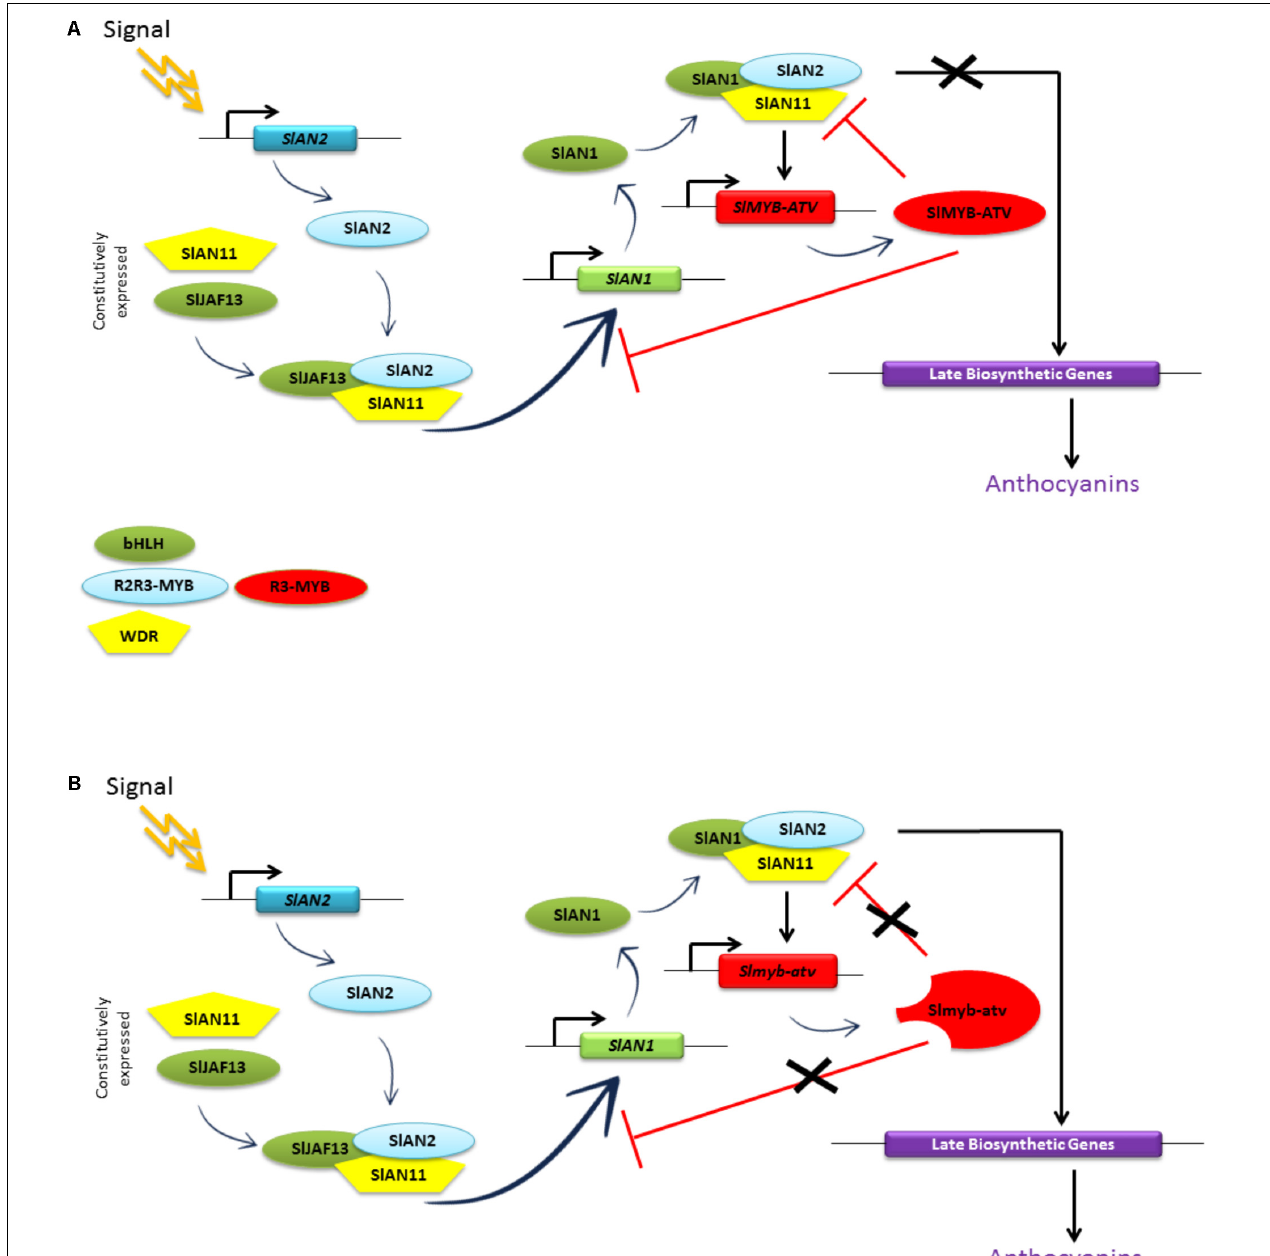
FIGURE 10 | Model of the anthocyanin regulation in: (A) wild type and (B) atv / atv tomato plants. “Signal” indicates an inductive environmental or developmental stimulus that triggers anthocyanin production in tomato plants. Rectangles represent gene sequences; ovals and pentagons represent proteins. Adapted from Albert et al.